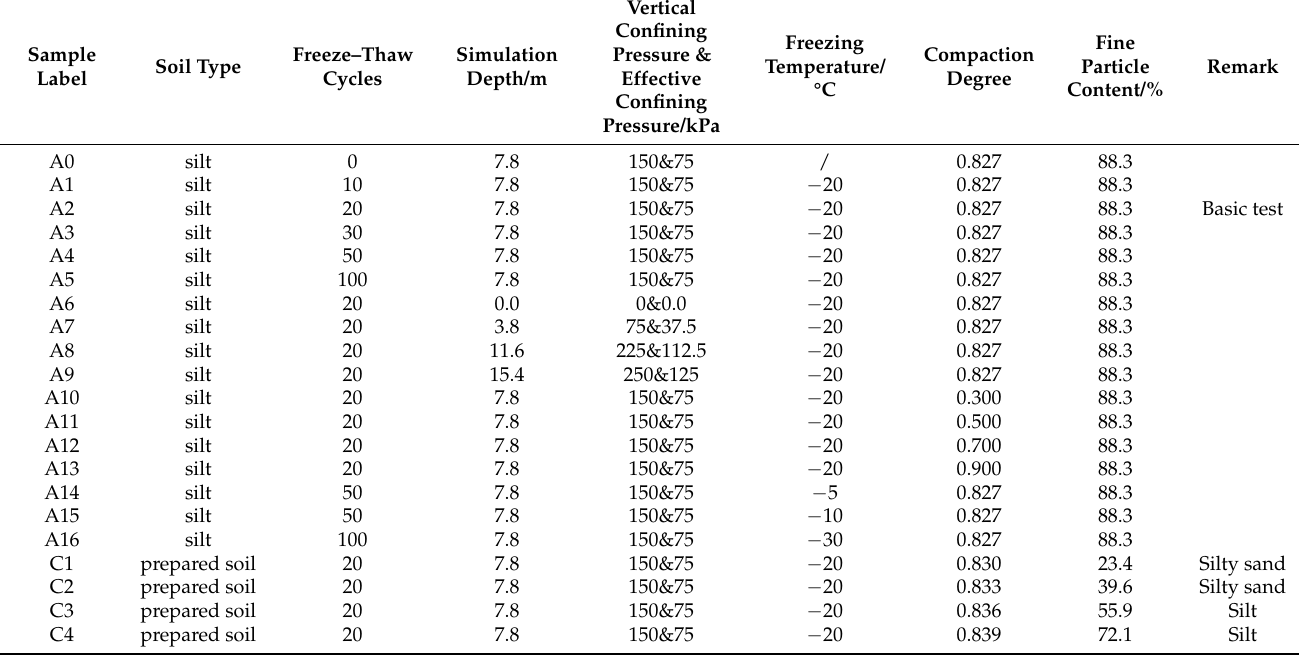
Table 2. Experimental